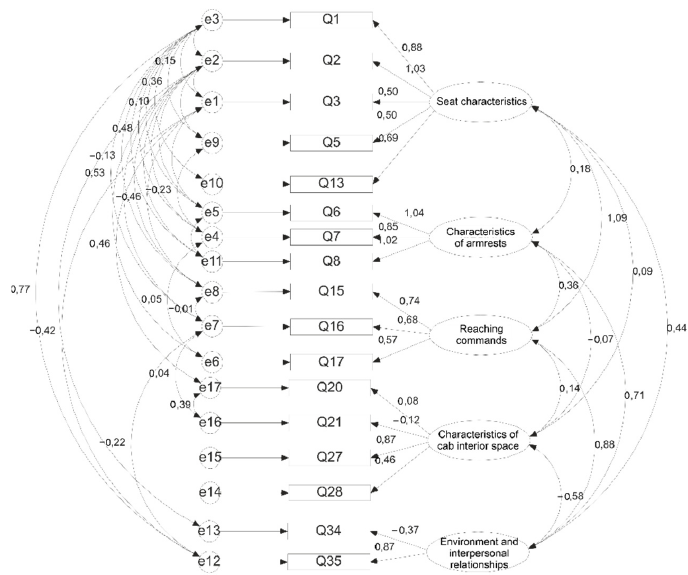
Figure 1. Confirmatory factor analysis model for heavy mobile machinery operators’ checklist.